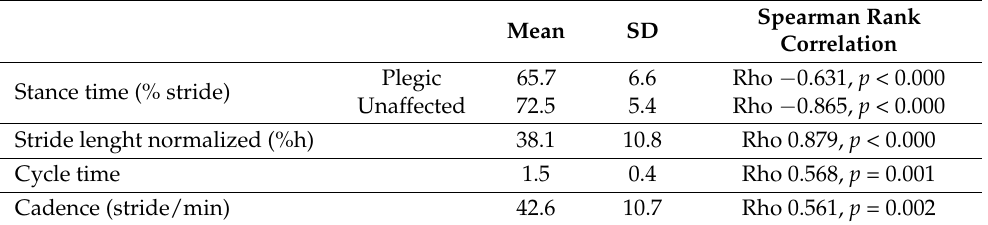
Table 4. Correlation between gait speed (cm/s) and time–distance